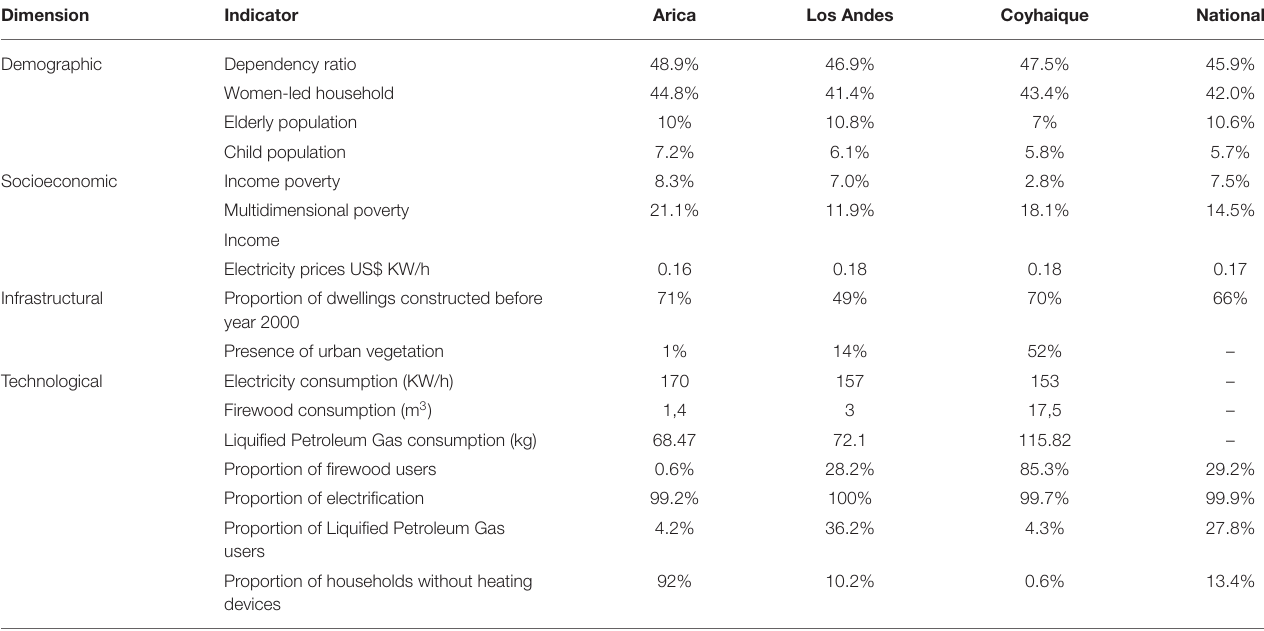
TABLE 4 | Case study sensitivity indicators.